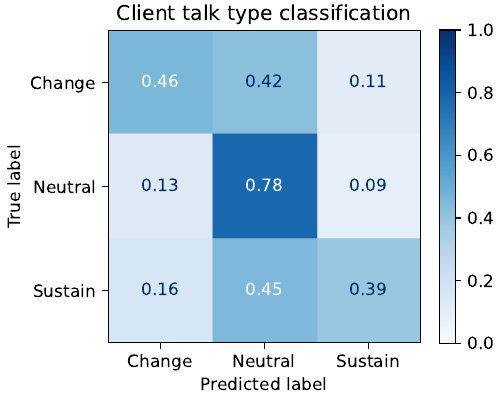
Figure 13. Confusion matrix of BERT w/ Adapters for client talk type prediction in the Original Unbalanced setting. Normalised by